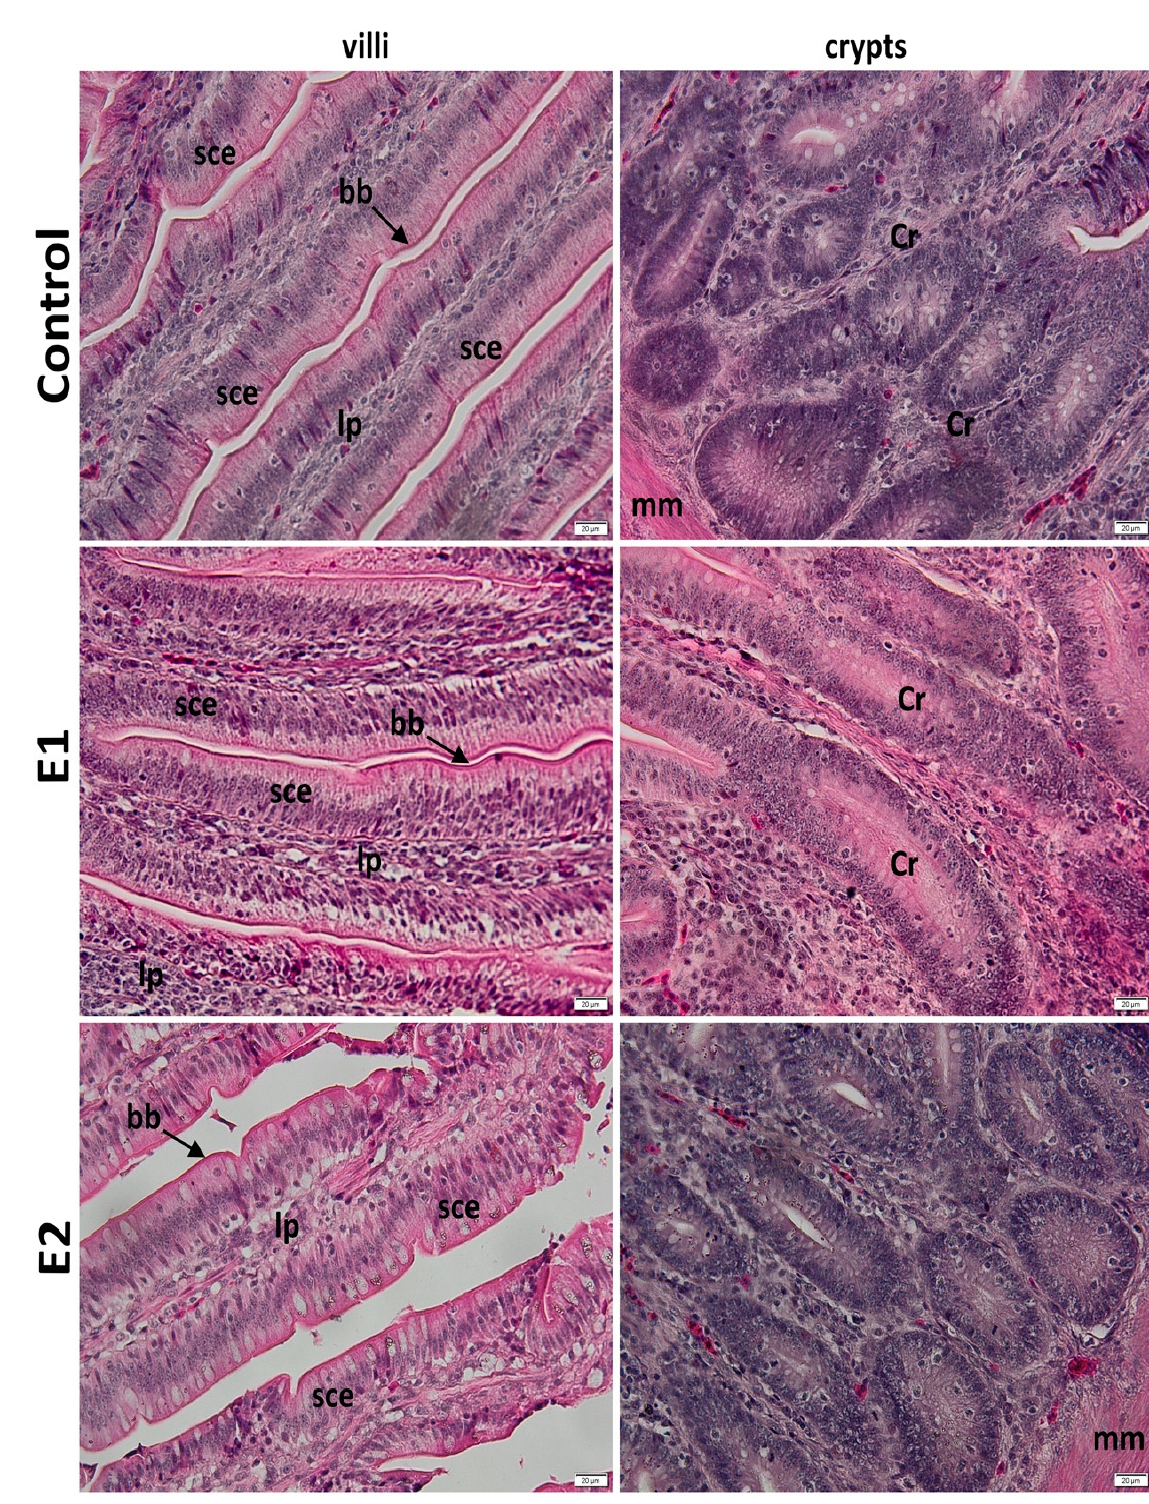
Figure 2. Effect of watermelon rind and sea buckthorn supplementation diet on the jejunal morphology of laying hens. The basal diet served as the control and the experimental groups were supplemented with watermelon rind (E1) and sea buckthorn (E2); sce, simple columnar epithelium; lp, lamina propria; cr, crypt; mm, muscularis mucosa. Bb, brush border; H&E (Hematoxylin and Eosin), Barr—20 μ m.